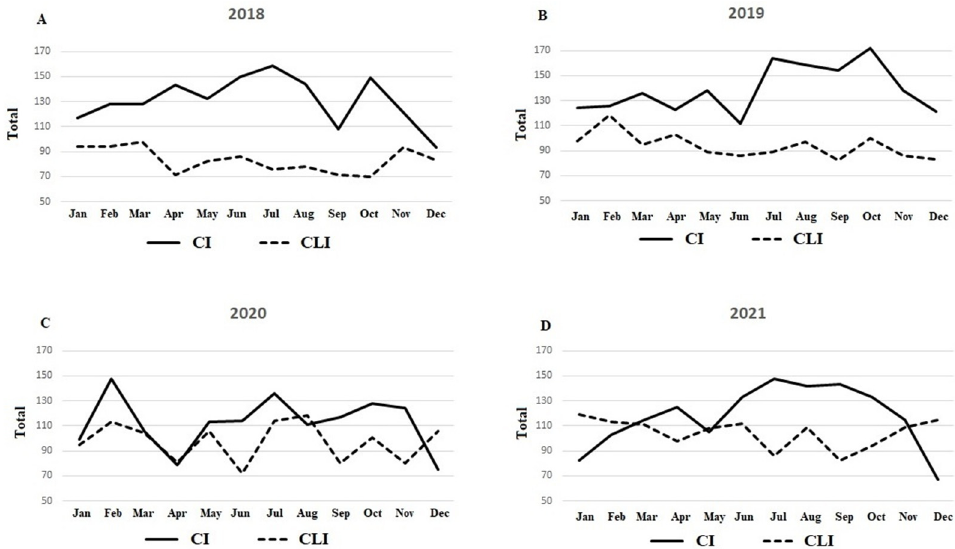
Figure 1. ( A – D ) Title: Number of interventions performed for intermittent claudication and CLTI for 2018 to 2021 by month.Legend: Number of interventions performed for intermittent claudication and CLTI for 2018 to 2021 by month. IC—intermittent claudication, CLTI critical limb-threatening ischaemia. Table 1. Cardiovascular risk factors.